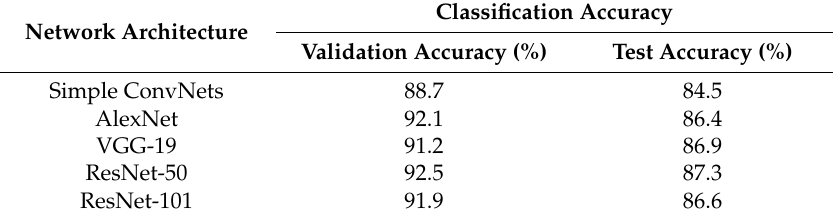
Table 5. Classification performance of simple ConvNet, AlexNet, VGG-19, ResNet-50, and ResNet-101 architectures for seed quality inspection based on morphology. The validation accuracy was obtained by using 10-fold cross-validation.